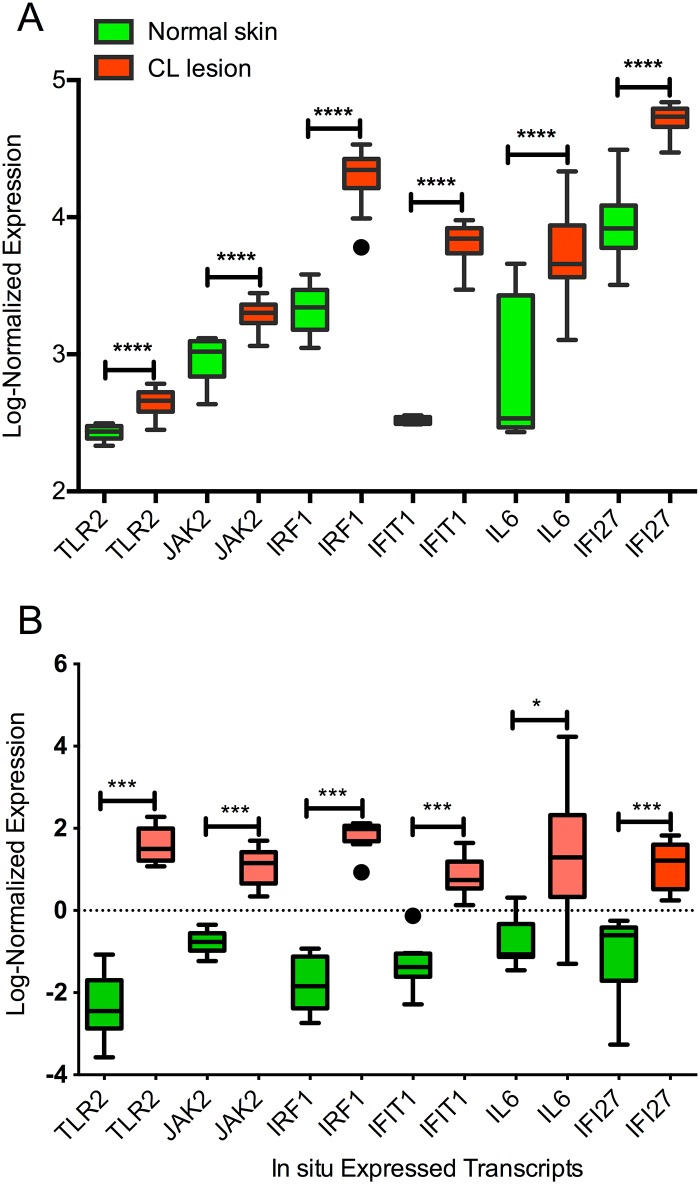
Genes modulated in High- IFN-γ producers are upregulated in CL lesions.The number of transcripts for each gene was quantified in Data sets GSM1341365 [12] and GSM1560512 [13]. Data were normalized using RMA (Robust Multichip Average) for each dataset, log-transformed expression for each gene is shown as box and whiskers (displaying quartile range) and outliers (identified by Tukey’s test). (t-test, ****p<0.0001, ***p<0.001, **p<0.01, *p<0.05).